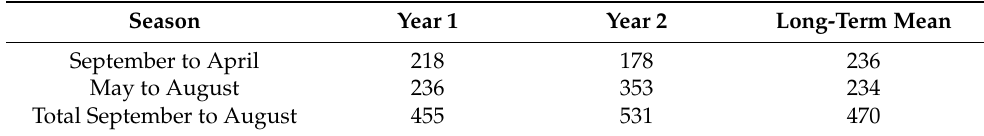
Table 1. Seasonal rainfall total (mm) for Lubbock, TX. Long-term mean is 106-year average from the nearest National Oceanic and Atmospheric Administration (NOAA) station (Lubbock